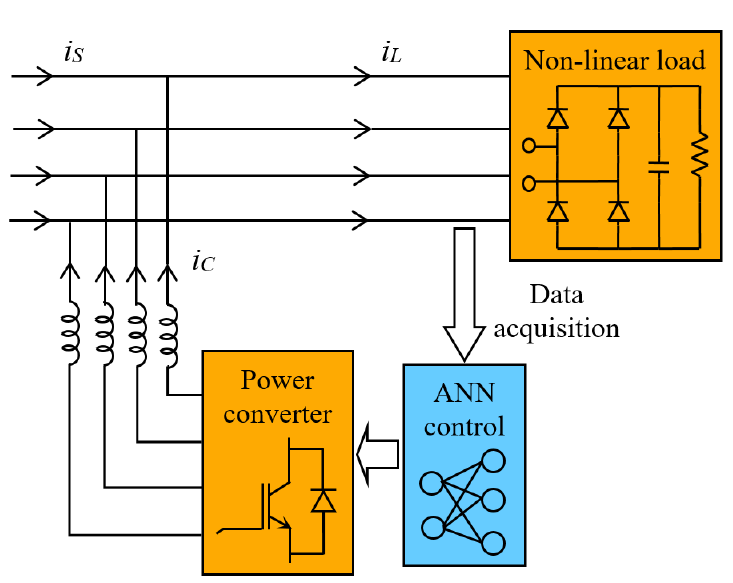
Figure 1. Typical nonlinear three-phase load compensated by a shunt APF, illustrating the power converter control based on neural networks.